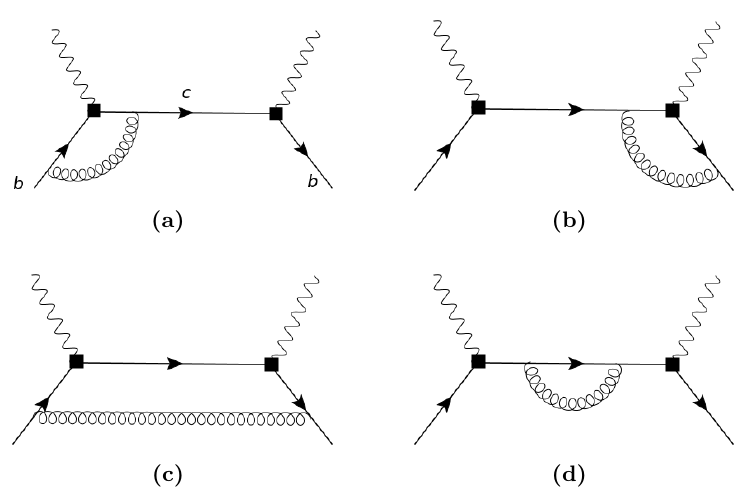
Figure 1. One-loop forward scattering diagrams which contribute to the b → X c ‘ ¯ ν ‘ differential rate at NLO. The black boxes represents one of the currents J the quarks, curly lines the gluons and wavy lines the color-singlet external current mediating the weak